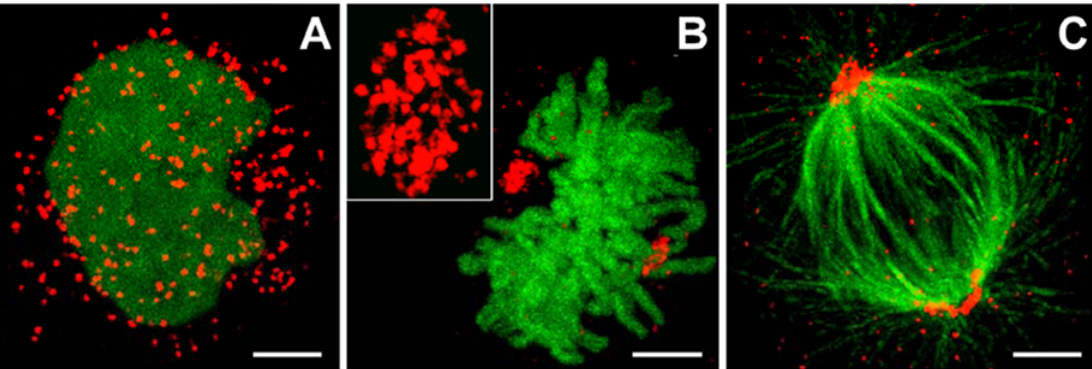
Figure 4. Peroxisome clusters in HEK293 cells. (A–C) Confocal images (Leica TCS 4Pi) of HEK293 cells co-expressing mRuby-PTS and H2B-EGFP during (A) interphase and (B) metaphase. The inset in (B) shows a magnification of a peroxisomal cluster. Tubulin fibers are labelled in green with